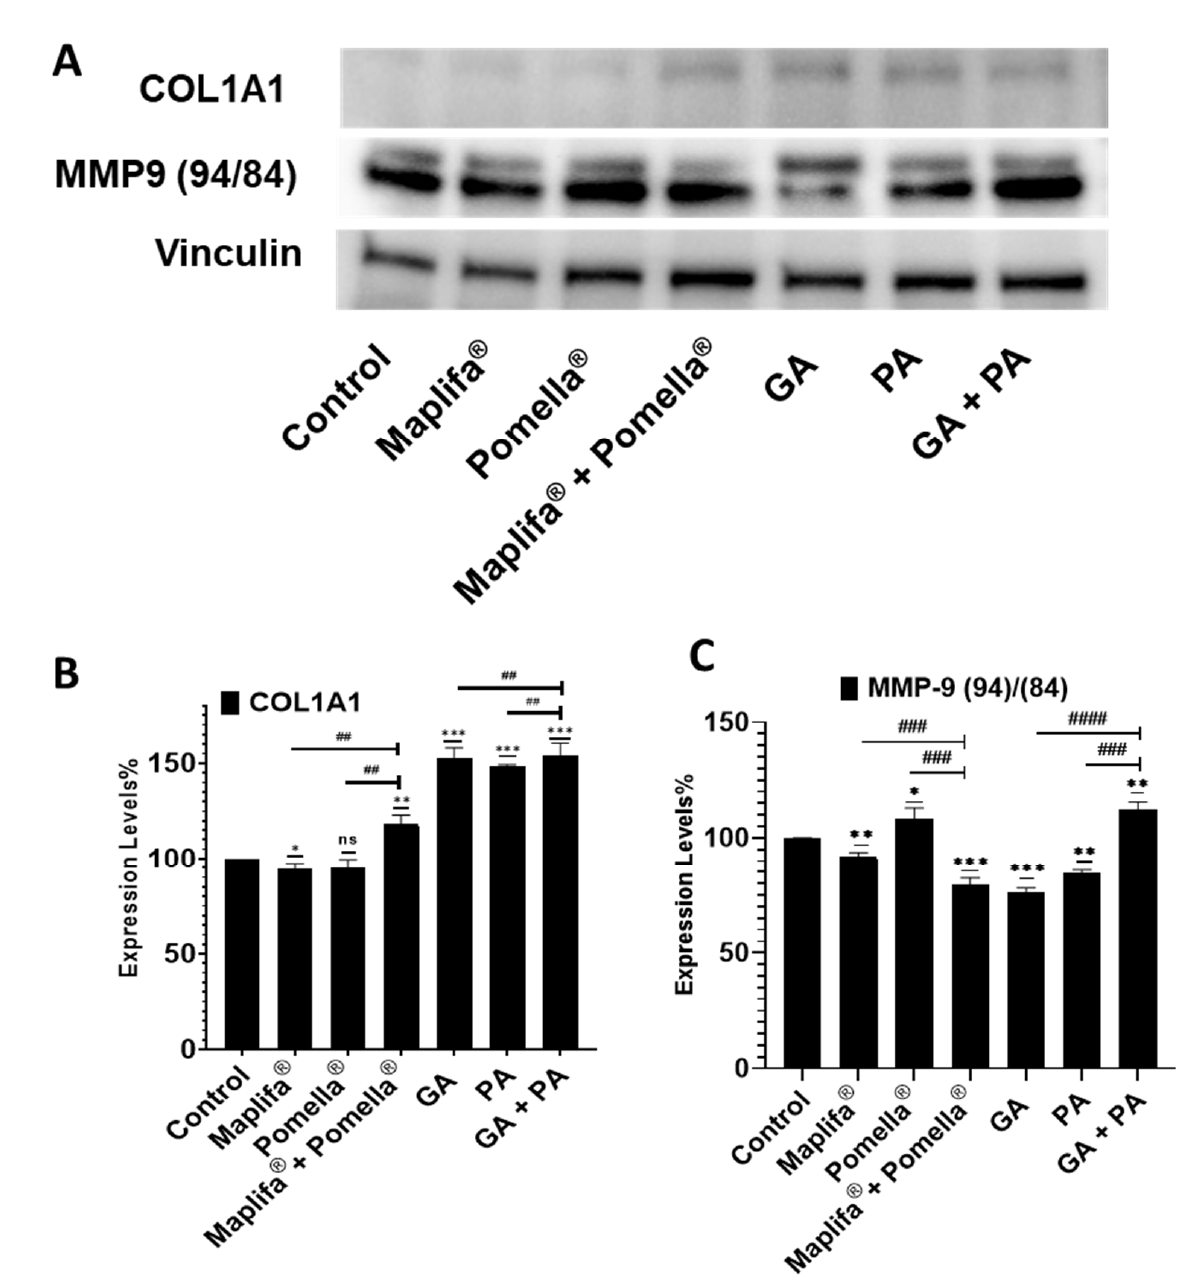
Figure 7. Induction of type I collagen (collagen 1A1) protein expression levels and modulation of matrix metalloproteinase 9 (MMP-9) after 48 h treatment of A431 with Maplifa ® (25 µg/mL), Pomella ® (12.5 µg/mL), Maplifa ® (25 µg/mL) + Pomella (12.5 µg/mL), GA (12.5 µM), PA (12.5 µM) and GA+PA (12.5 µM) by Western blotting. The inductive or inhibitory effects were analyzed by Western blot assay of A431 cell lysates ( A ). Data are expressed as means ± standard deviation (S.D.) from three independent experiments each performed in duplicate ( B , C for collagen 1 A1 and MMP9 respectively). Statistically significant difference was considered, not significant (ns) compared to control, * p < 0.05, ** p < 0.01, *** p < 0.001 when compared to the control group and ## p < 0.01, ### p < 0.001, #### p < 0.0001 when compared between individual treatment groups.